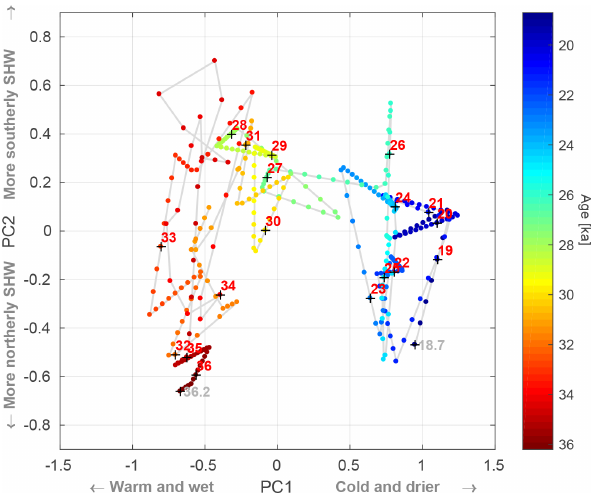
Figure 9. Parametric plot of the PC1 and PC2 sample values as a function of time shown by the color bar to the right. Red num- bers denote each age with gray numbers at the start and end of the plot. Data were interpolated to 50-year time steps to illustrate rate of change; the larger the distance between dots, the more rapid the change. Note that the hydroclimate interpretations from Fig. 6b are shown on the two PC